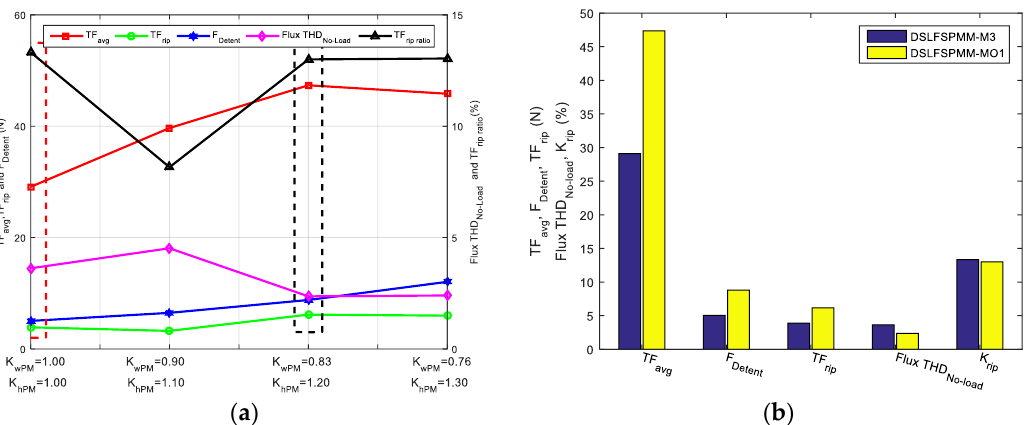
Figure 11. Influence of PM dimensions on DSLFSPMM-M3, when PM volume is constant: ( a ) Comparison of DSLFSPMM-M3 with different 𝐾 𝑤𝑃𝑀 and 𝐾 ℎ𝑃𝑀 values; ( b ) Comparison of DSLFSPMM-M3 and DSLFSPMM-MO1. Table 7. Modified parameters and performance comparison of DSLFSPMM-M3 with DSLFSPMM-MO1.